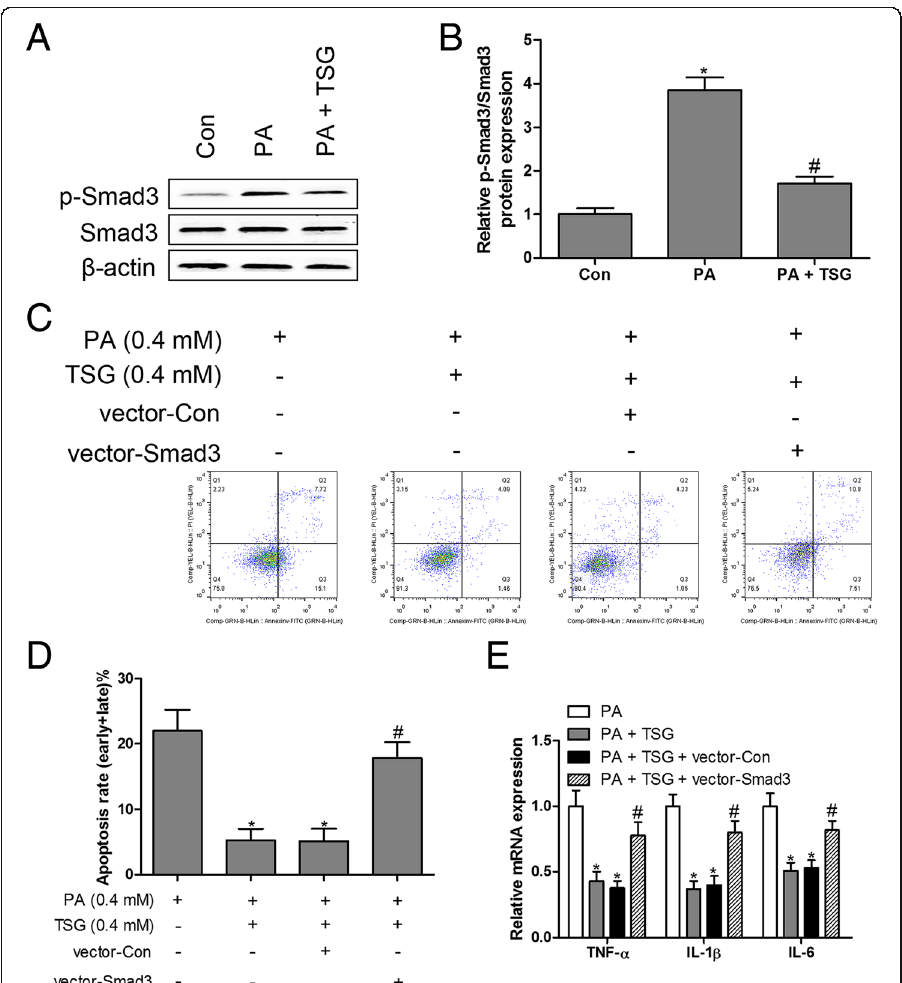
cells transfected with Smad3 overexpressed plasmids and treated with PA (0.4 mM) and TSG (0.4 mM) for 48 h, cell apoptosis was detected by flow cytometry ( c and d ); RT-qPCR was performed to measure